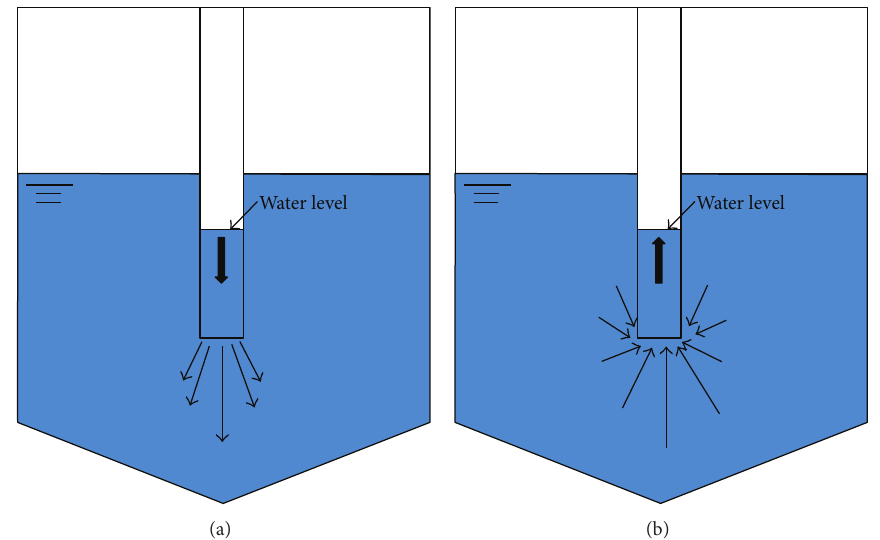
Figure 6: Separate effect during chugging regime when steam is injected through vertical pipe, (a) injection phase and (b) suction phase.